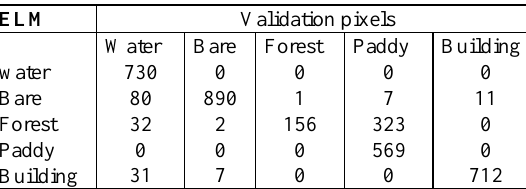
Table 4. Confusion matrix of ELM on Wuhan image experiment